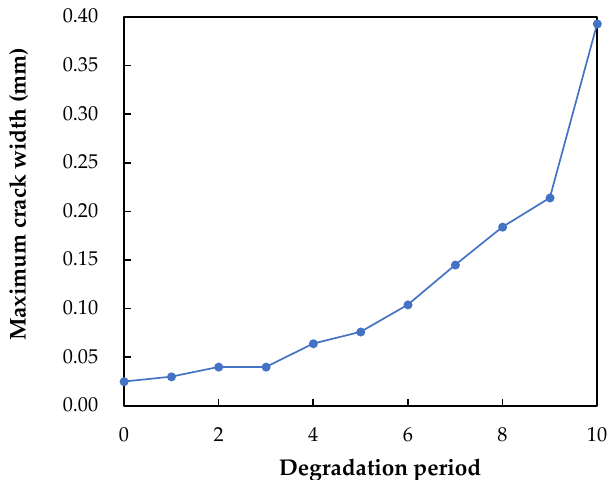
Figure 7. Maximum crack widths measured on the surface of degraded reinforced concrete beams in the degradation periods 0–10.